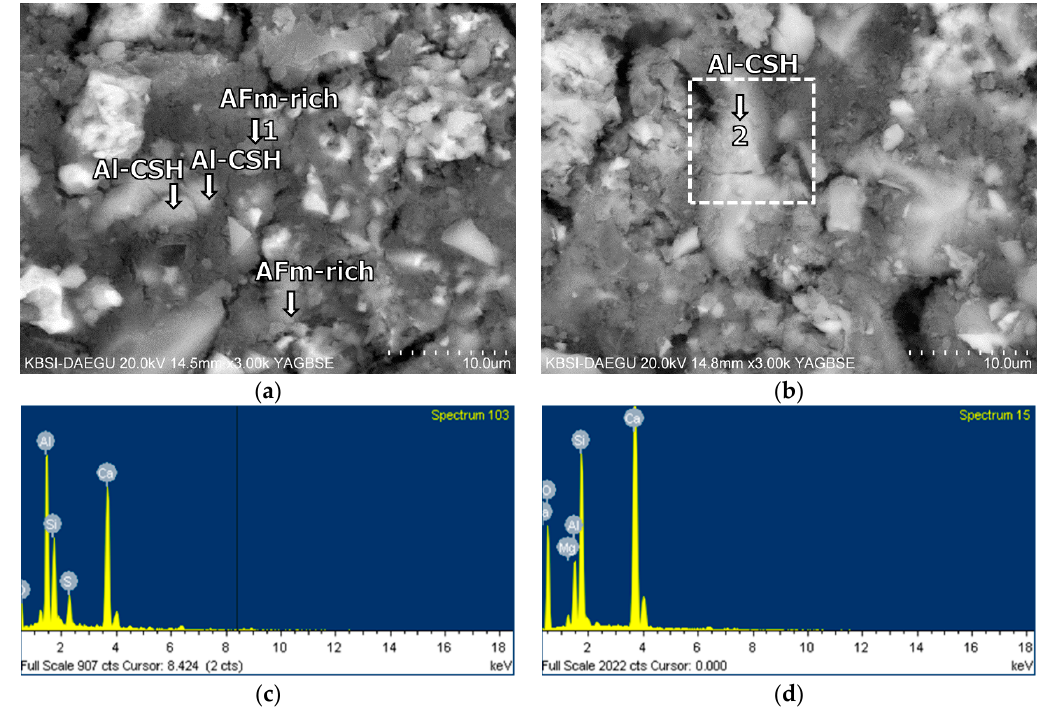
Figure 16. The microstructures of mixture B-10-Y at 60 days: BSE images magnified by ( a ) ×3000; and ( b ) ×3000; EDS spectra of ( c ) point 1 in ( a ); and ( d ) point 2 in ( b ).